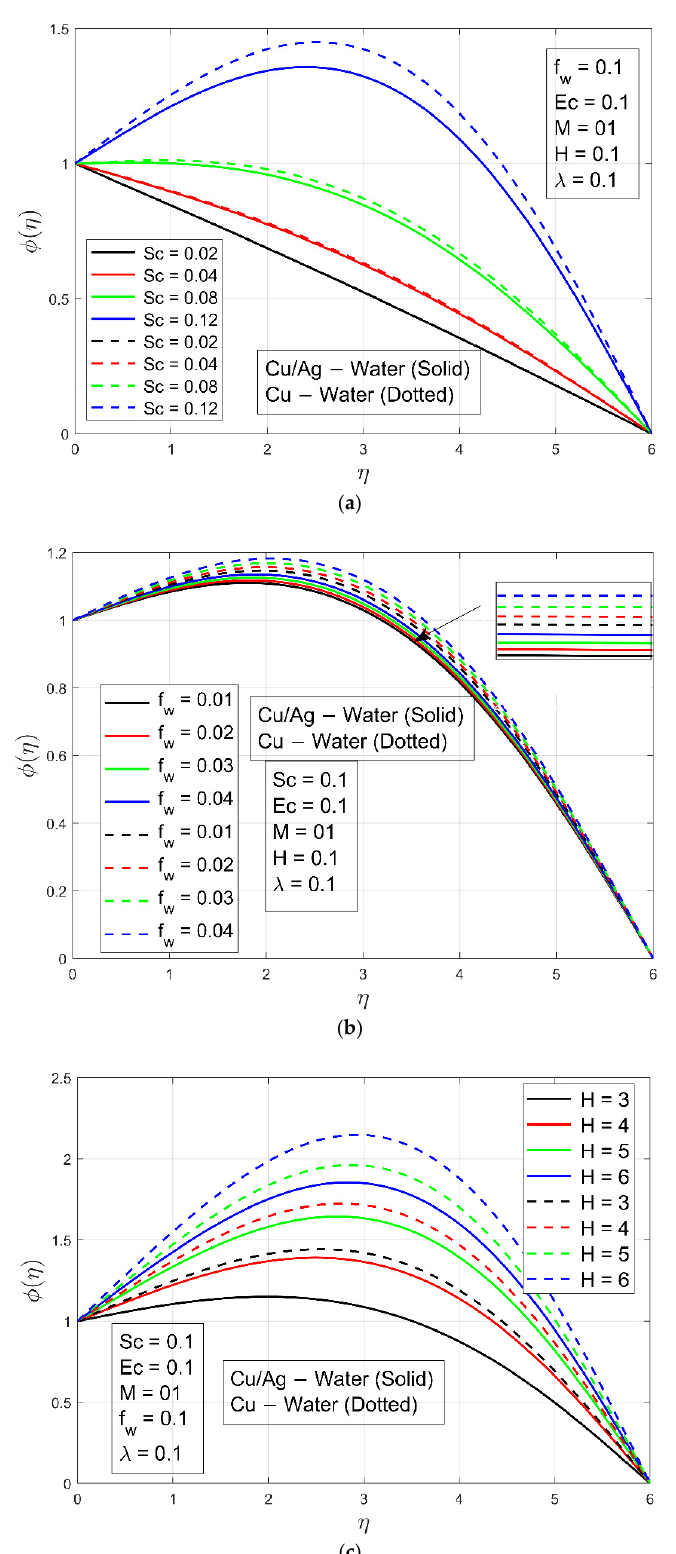
Figure 7. ( a ) Concentration profile φ ( η ) under the impact of Schmidt number Sc . ( b ) Concentration profile φ ( η ) under the impact of Stefan blowing parameter f w . ( c ) Concentration profile φ ( η ) under the impact of Hall parameter H